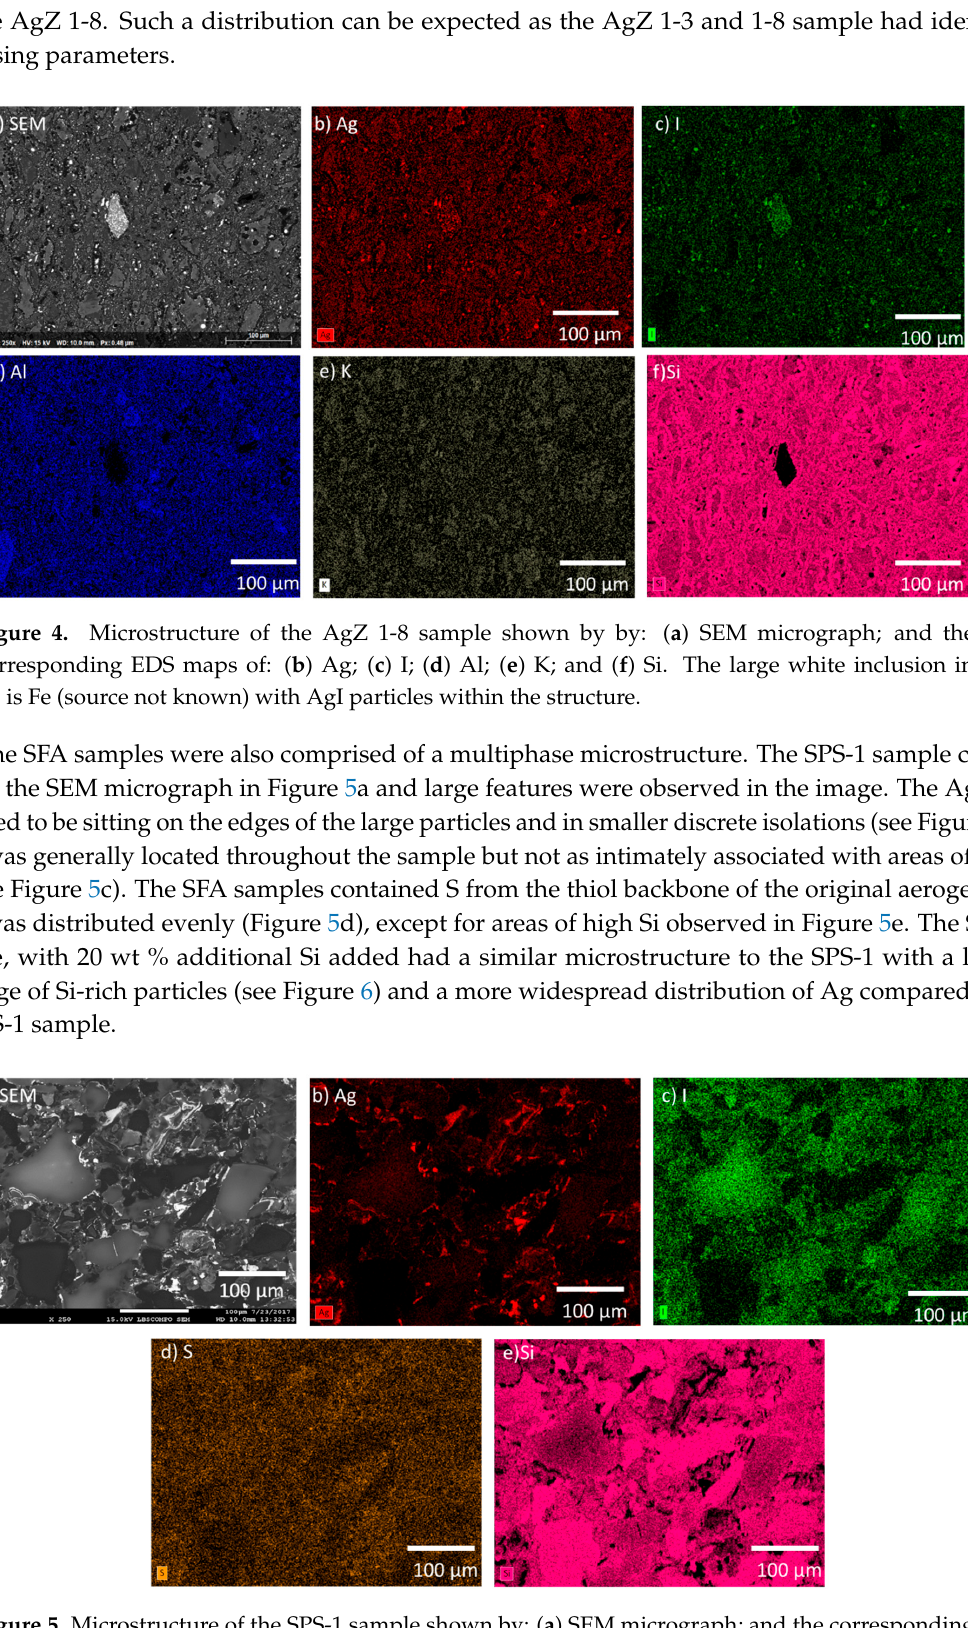
Figure 3. Microstructure of the AgZ 1-7 sample shown by: ( a ) SEM micrograph; and the